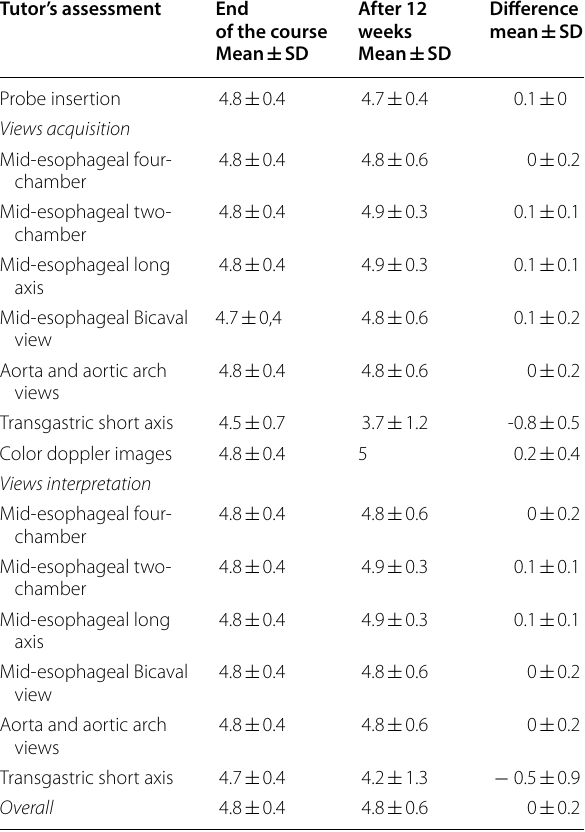
Table 1 Probe insertion, acquisition, and interpretation of